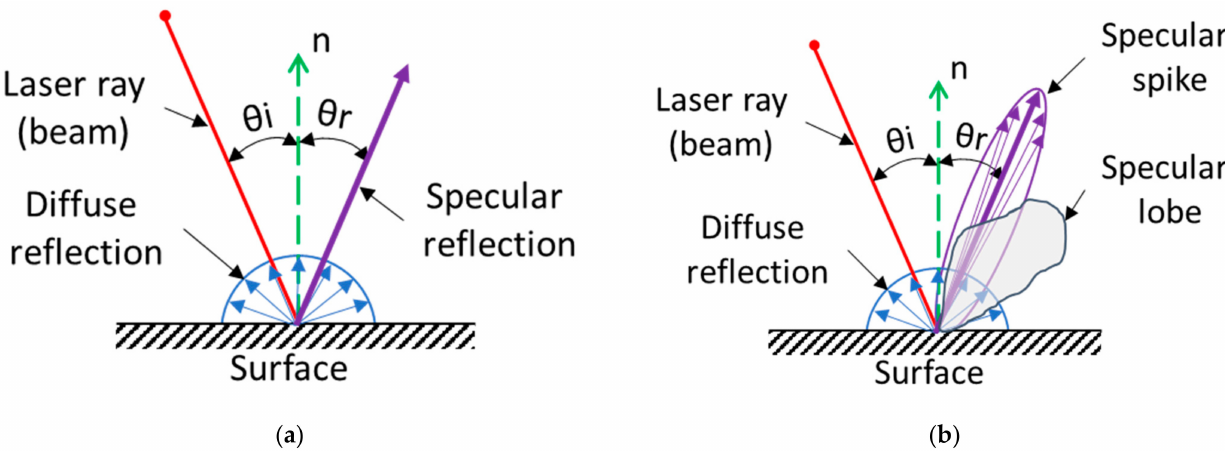
Figure 1. Reflection phenomenon. For an ideal specular reflection, the angle of incidence (AoI) θ i is the same as the angle of reflection θ r relative to the surface normal n; ( a ) the general distribution of the reflection; ( b ) the distribution of the reflection by